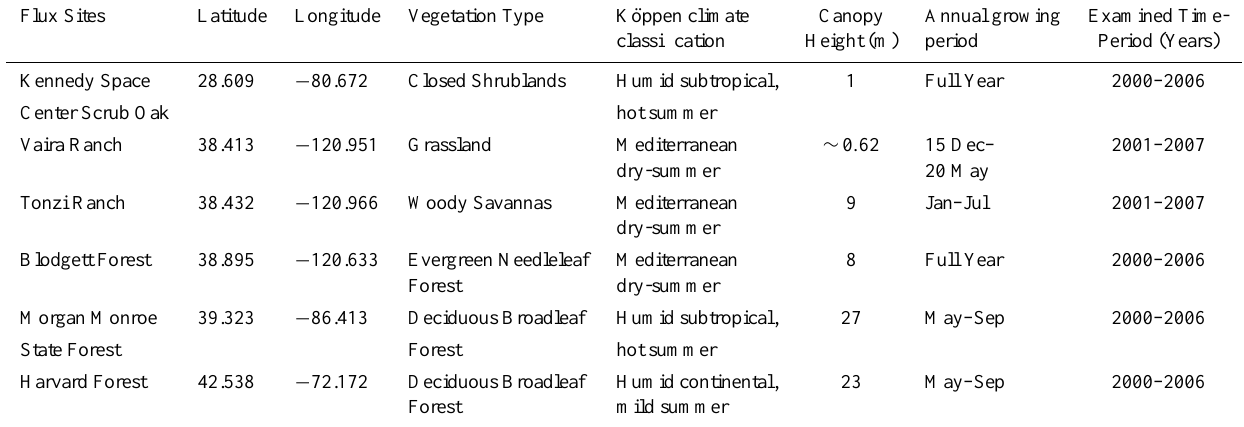
Table 1. Description of AmeriFlux sites used in the analysis. Note that the Kennedy Space Center Scrub Oak site is referred to as “Kennedy Space Center” in subsequent tables and figures, and the Morgan Monroe State Forest site is referred to as “Morgan